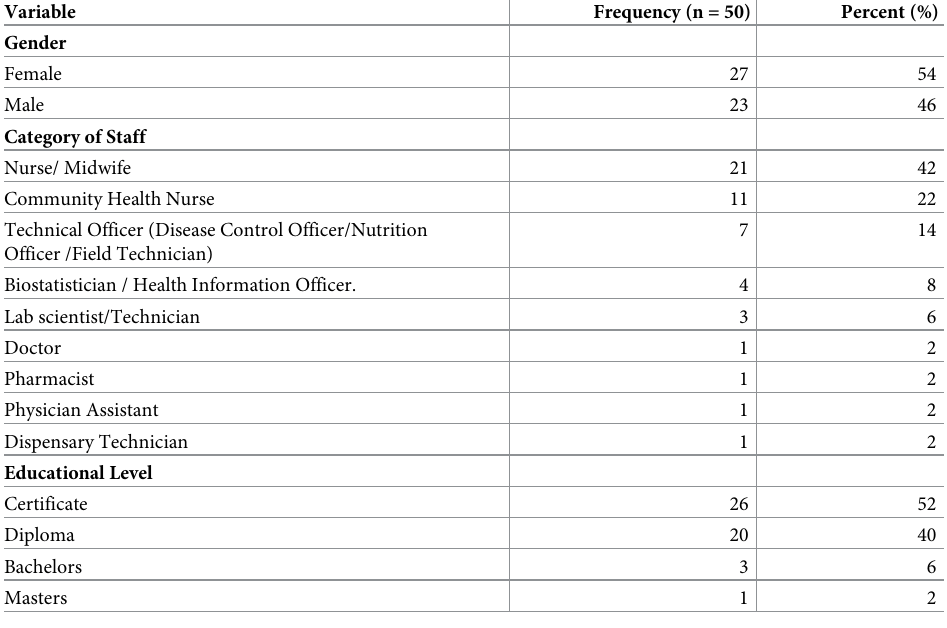
Table 3. Socio-demographic characteristics of